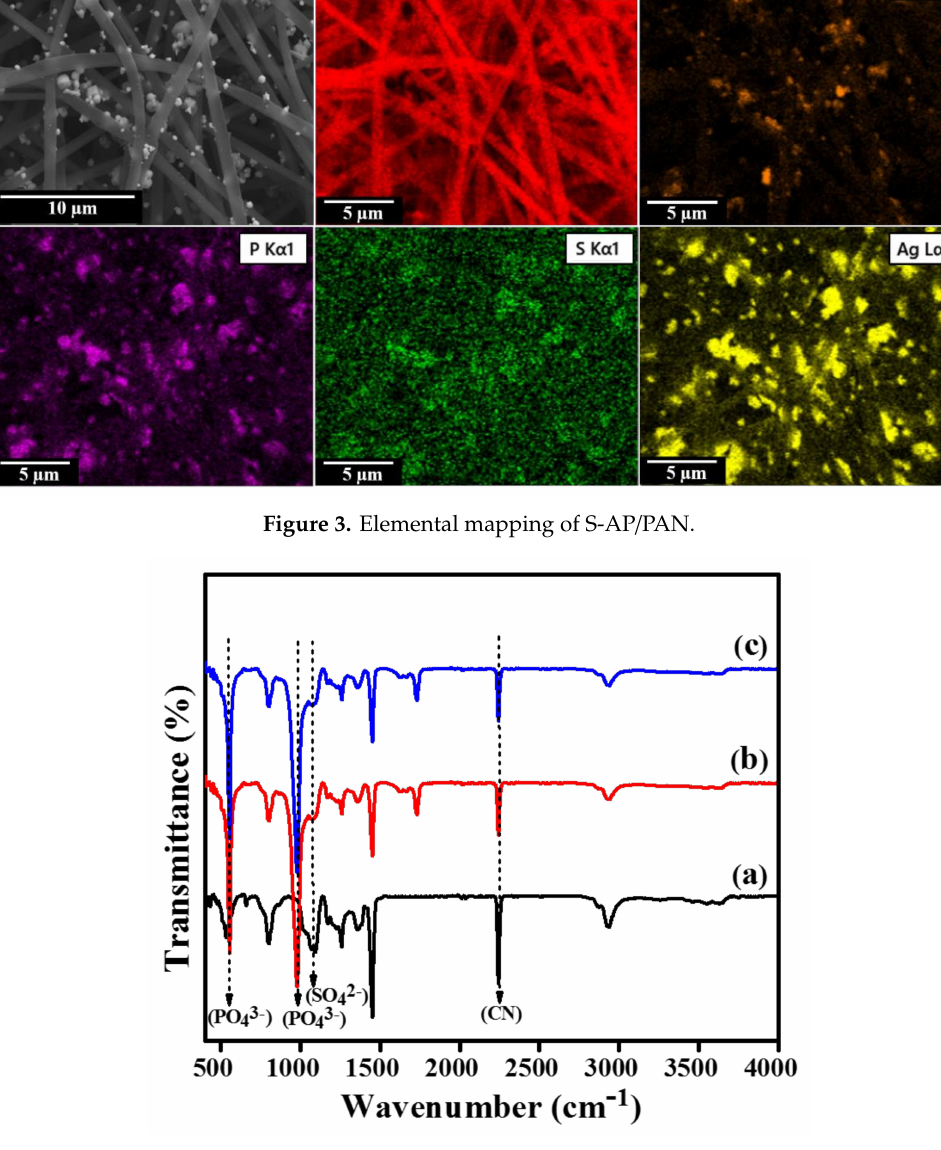
Figure 4. FTIR spectra; ( a ) pure PAN, ( b ) AP / PAN and ( c ) S-AP /